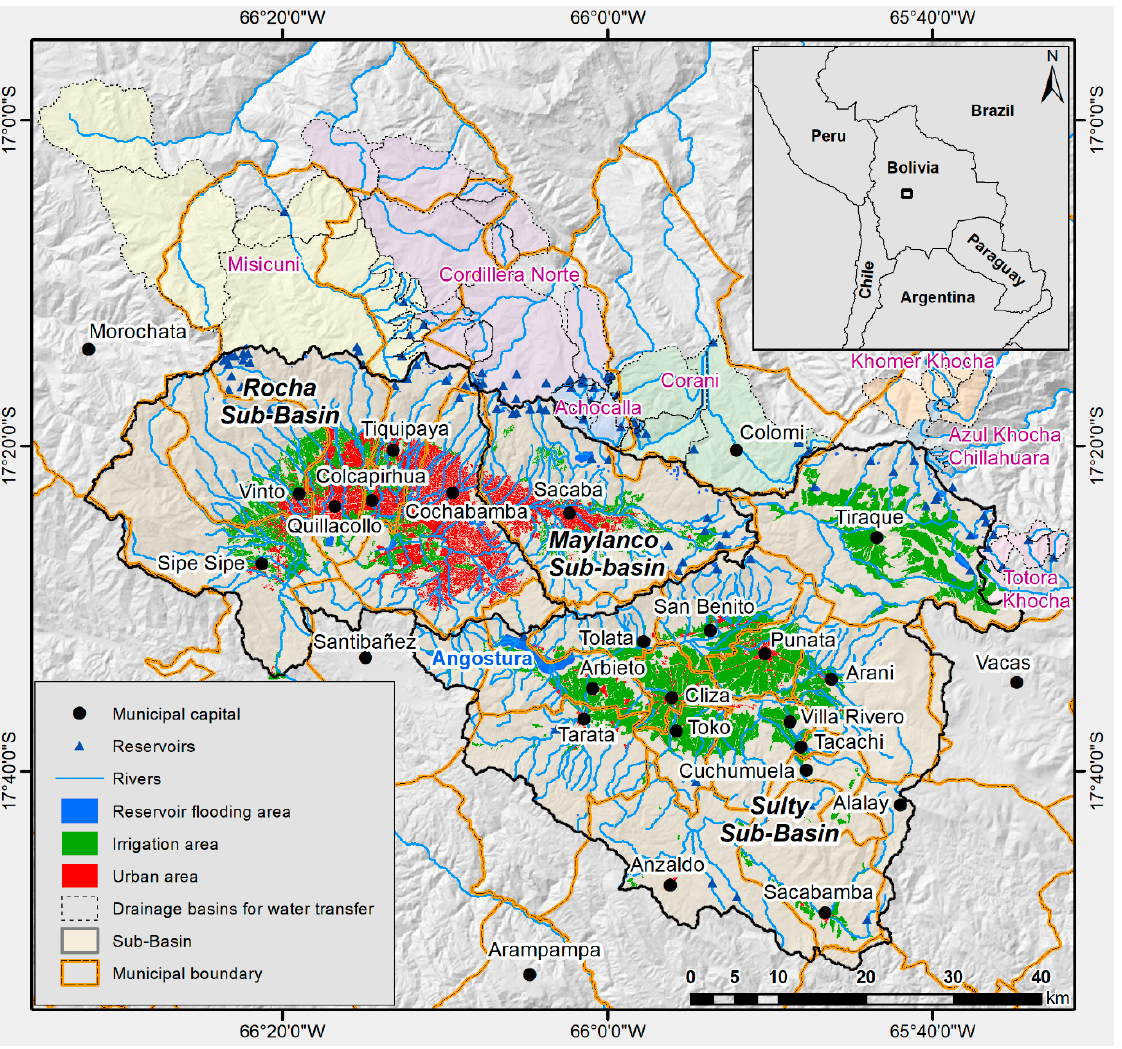
Figure 1. The Rocha River Basin and its geographical environment related to the urban area, agriculture, and the different hydrographic